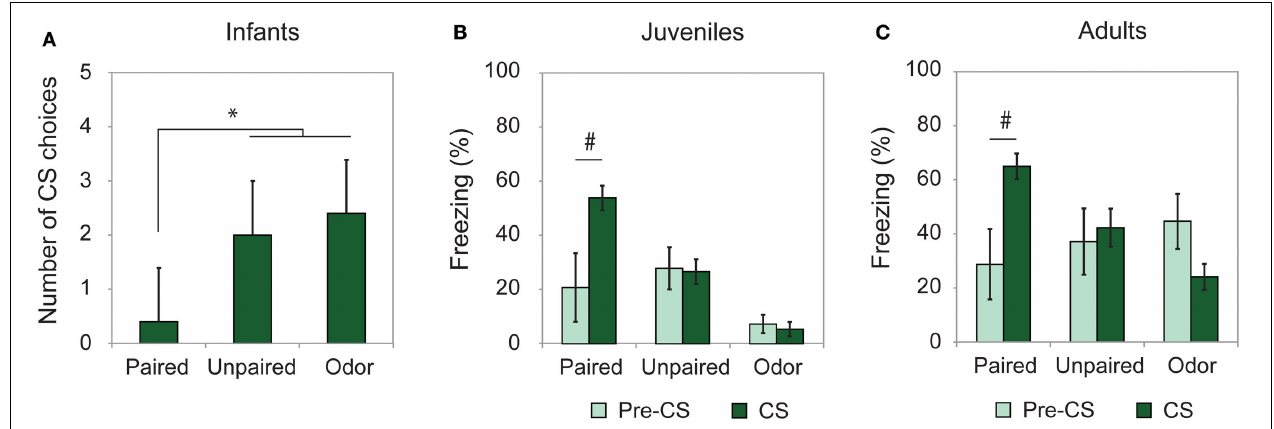
FIGURE 1 | Learning retention session. Animals were tested the day after conditioning. (A) Infant rats (Paired, n = 5; Unpaired, n = 6; Odor, n = 6) were given a Y-Maze test and the number of CS choices (mean ± s.e.m.) out of 5 were used as a measure of learning. (B) Juveniles (Paired, n = 7;